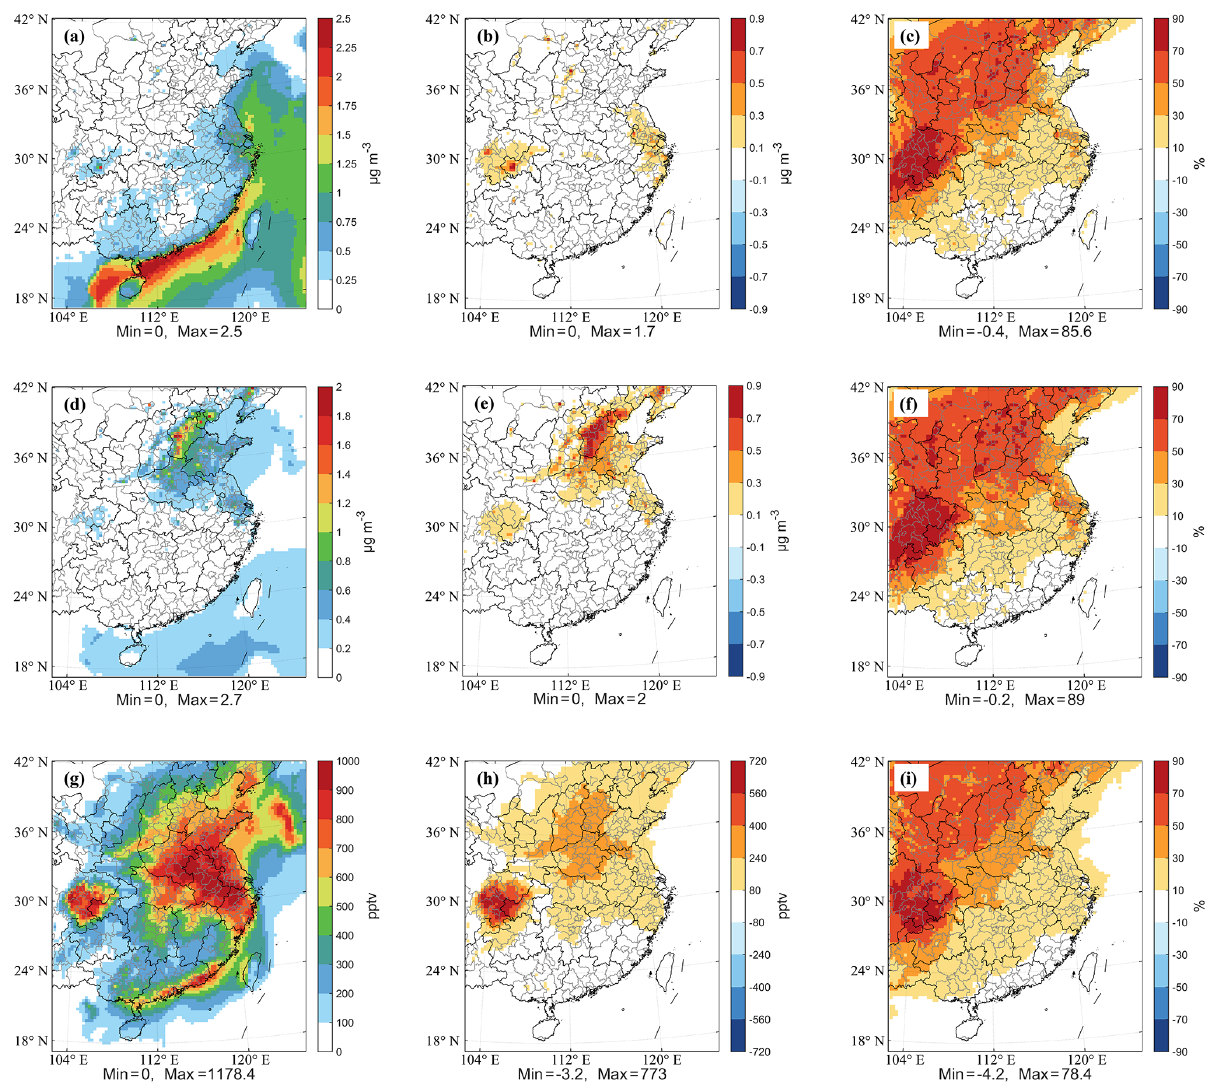
Figure 4. Spatial distributions of modeled HCl (a) , fine particulate Cl − (d) , and daily maximum 1h ClNO 2 (g) average concentrations in November 2011 in the Base experiment; the differences (Base minus NoCl) of modeled HCl (b) , fine particulate Cl − (e) , and daily maximum 1h ClNO 2 (h) average concentrations in November 2011; the percent changes of the NoCl experiment to the Base experiment of modeled HCl (c) , fine particulate Cl − (f) , and daily maximum 1h ClNO 2 (i) average concentrations in November